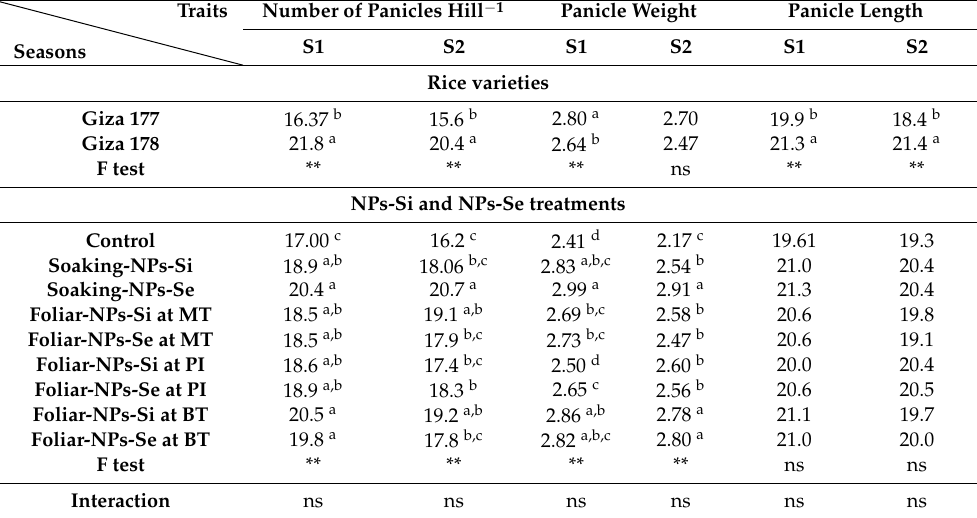
Table 6. Effect of NPs-Si and NPs-Se treatments on number of panicles, panicle weight, and panicle length of two rice varieties under saline soil conditions in the 2018 (S1) and 2019 (S2) seasons. Traits Number of Panicles Hill − 1 Panicle Weight Panicle Length Seasons Rice